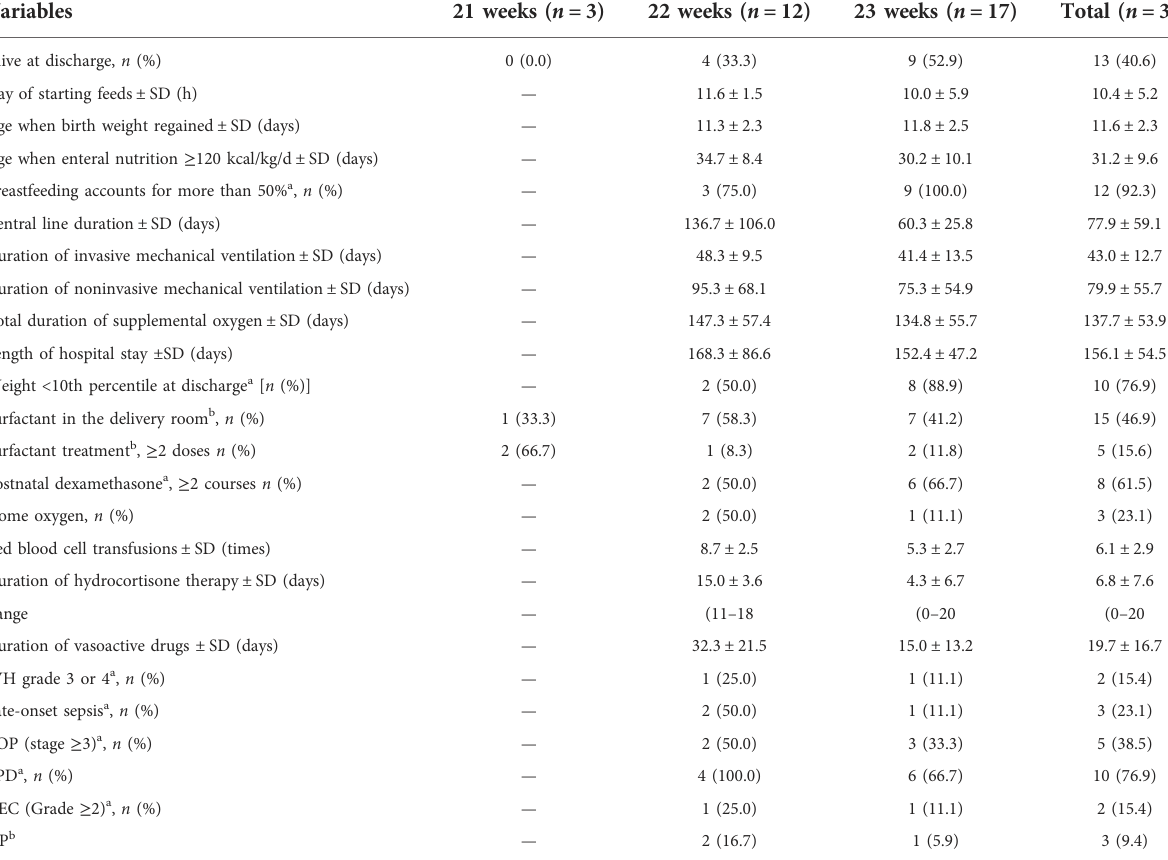
TABLE 2 Care practices and morbidities for the infants according to gestational age.